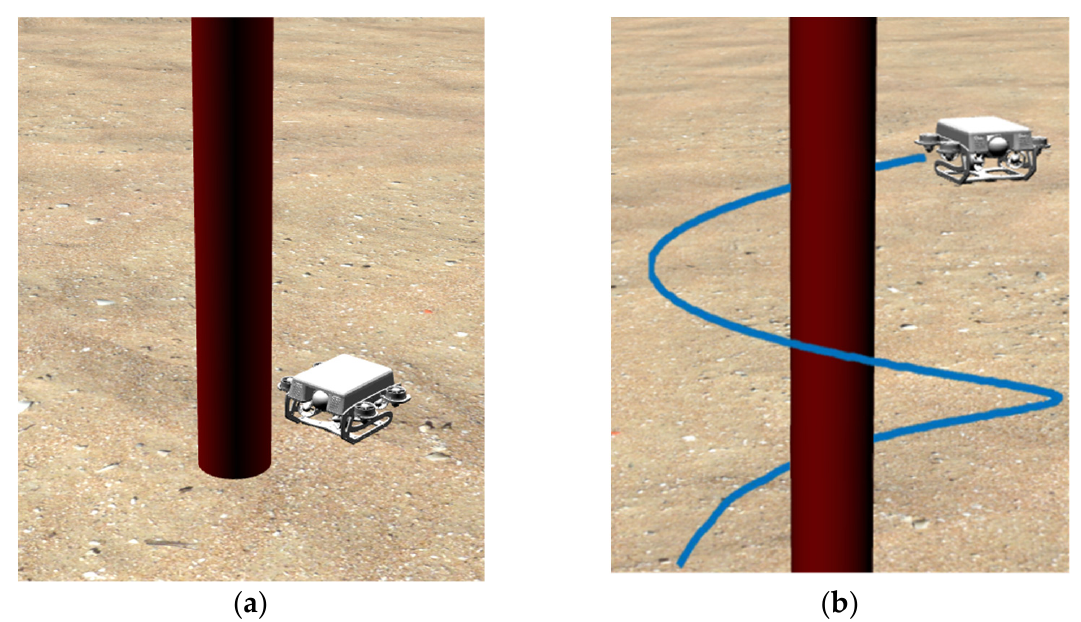
Figure 4. Structure and thruster distribution of an AUV.